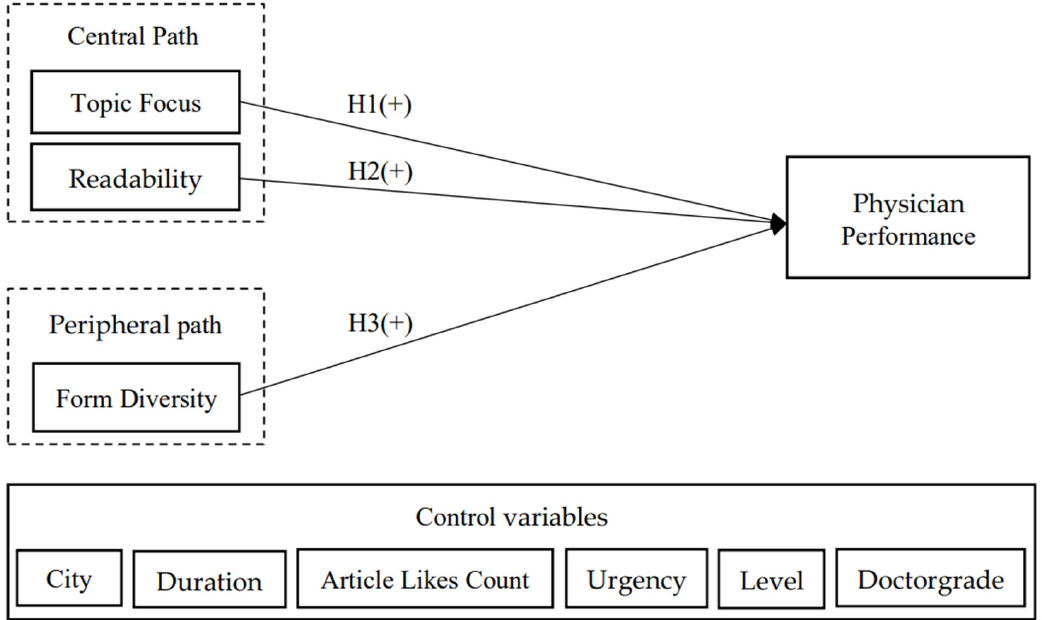
Figure 1. Research Figure 1. Research Model.